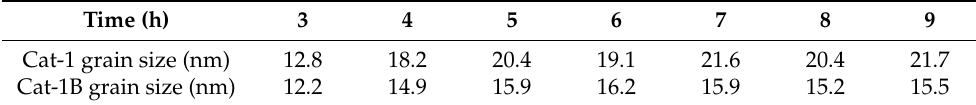
Figure 11. In situ XRD patterns of ( a ) Cat-1 and ( b ) Cat-1B. Table 9. Grain size of Fe 5 C 2 at different reduction